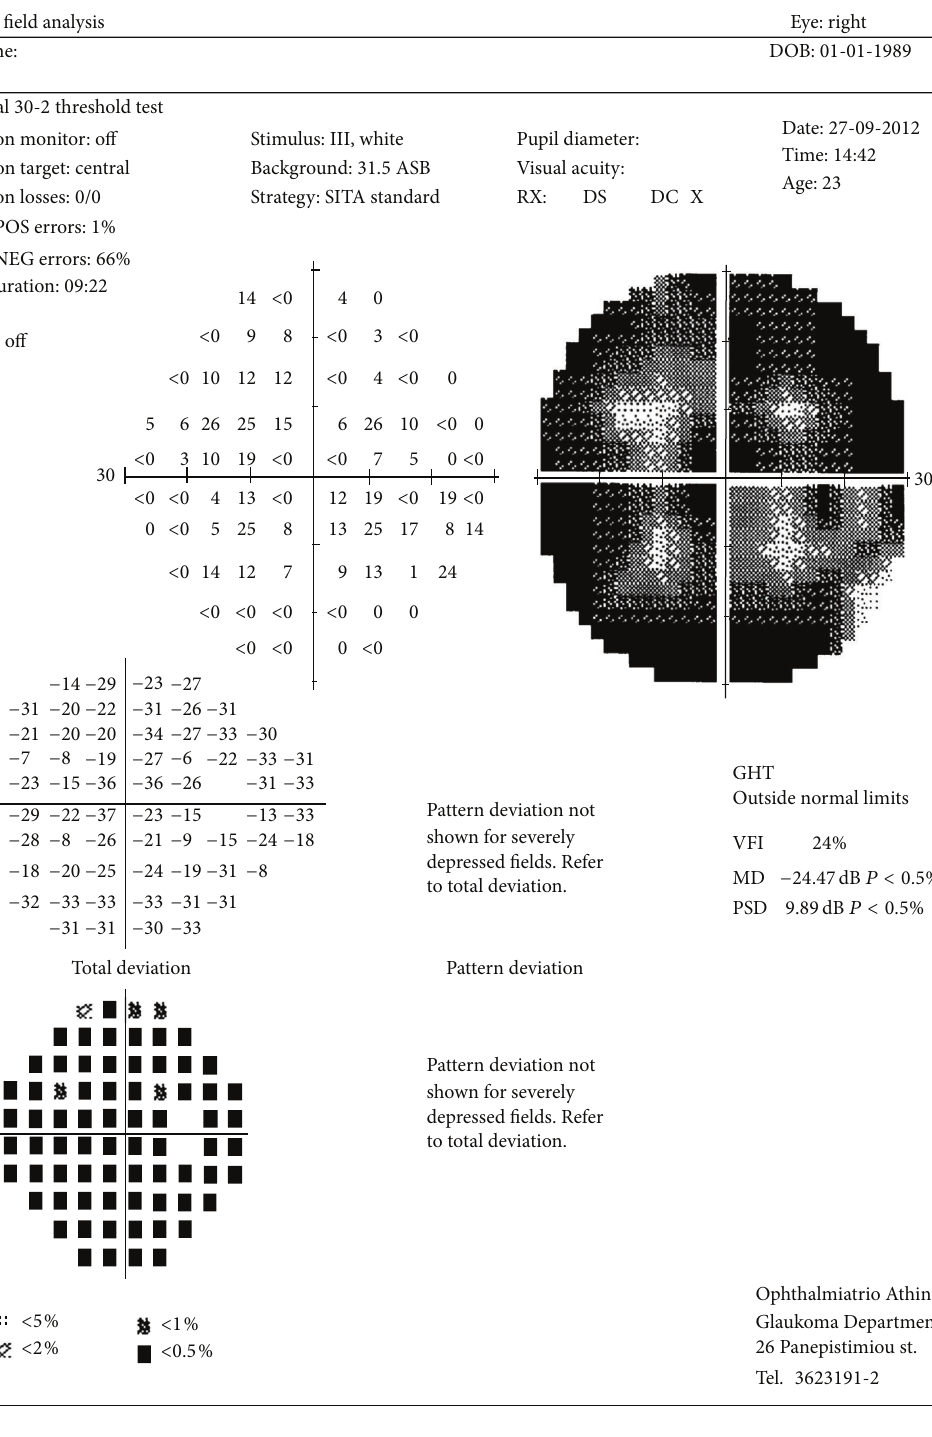
Figure 1: Visual field of the patient’s right eye demonstrating a generalized